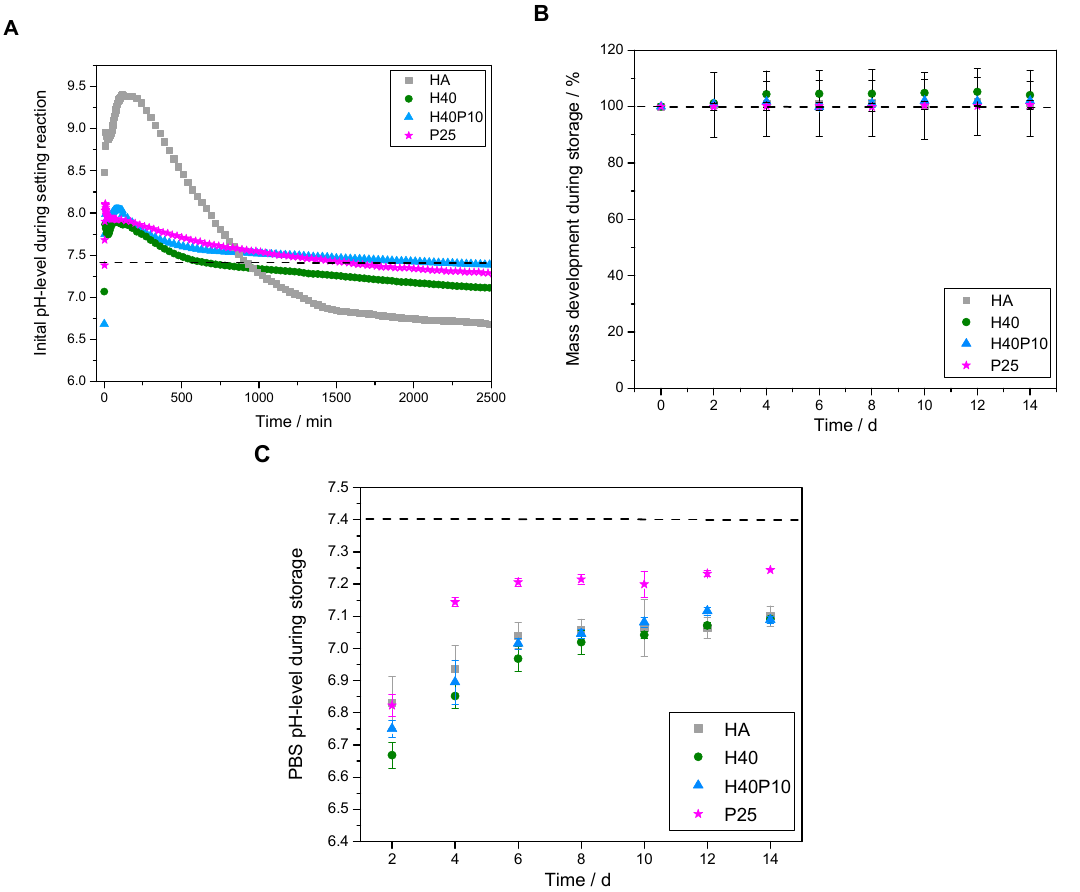
Figure 6. Analysis of different parameters for characterization of composite formulations. Regarding material technological relevance, initial pH-level during setting was measured ( A ). Furthermore, mass development during storing was observed ( B ). With respect to biological relevance, pH-level of PBS storage solution was determined ( C ).